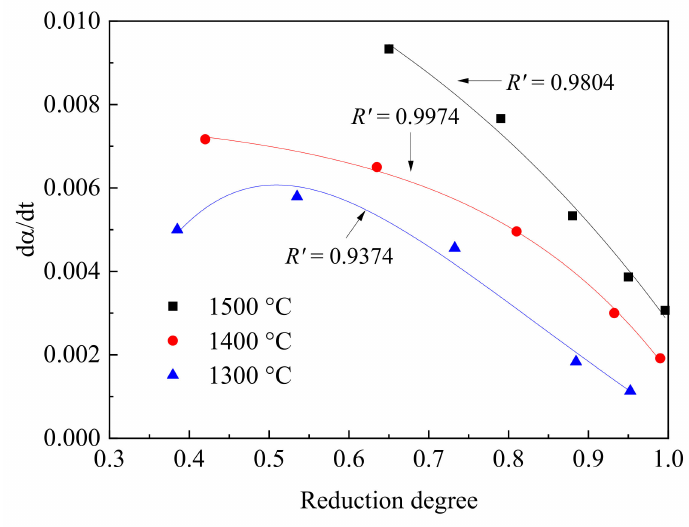
Figure 10. The relationship of reduction rate ( d α / dt ) and reduction degree at different temperatures. R (cid:48) denotes the correlation